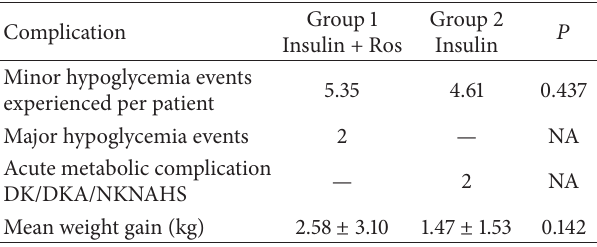
Table 4: Complications observed in the